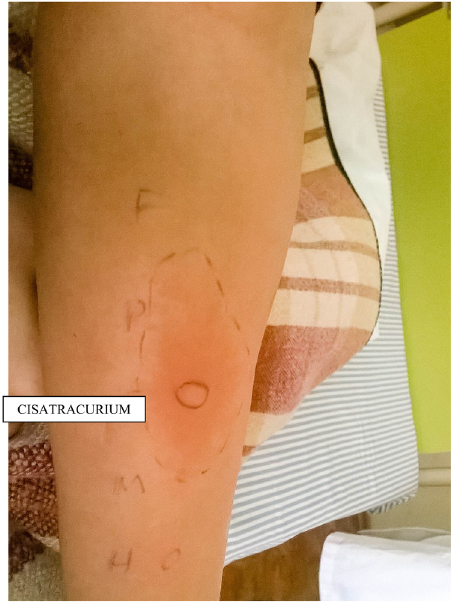
Figure 1: Positive skin prick test to cisatracurium. The diameter of a wheal is 9 mm, erythema – 55 mm.